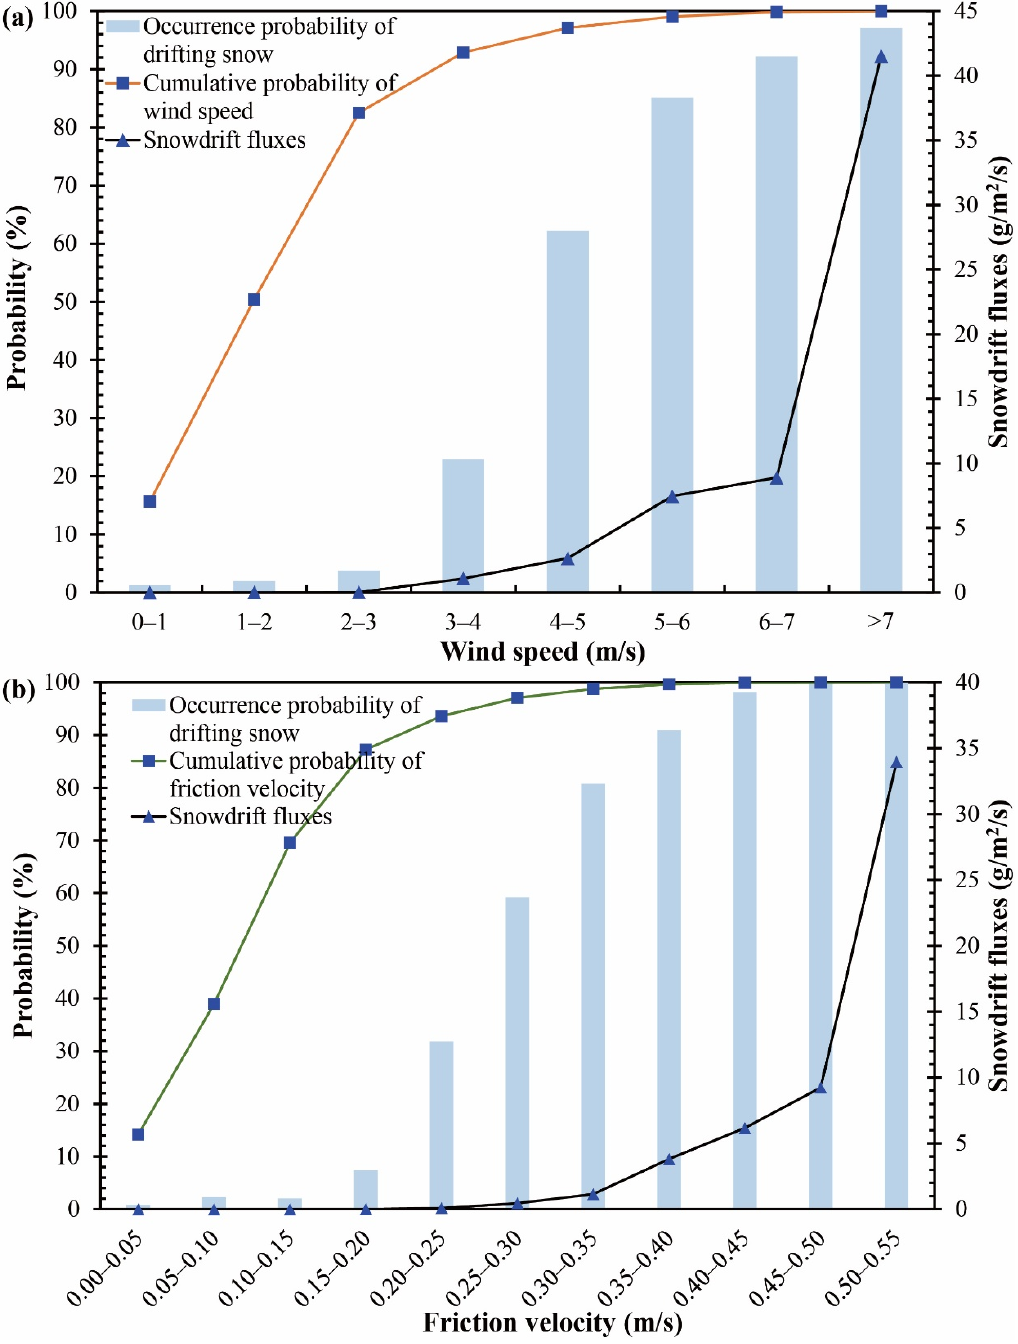
Figure 5. The cumulative probability of wind speed and friction velocity and the relationships be- tween the probability and snowdrift flux of drifting snow and wind speed ( a ) and friction velocity ( b